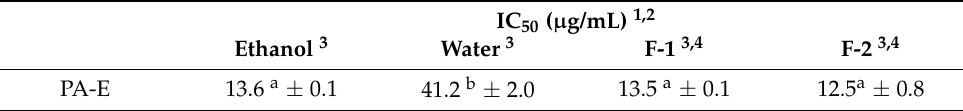
Table 3. Antioxidant activity of free PA-E and nanoencapsulated formulations obtained from U. tomentosa